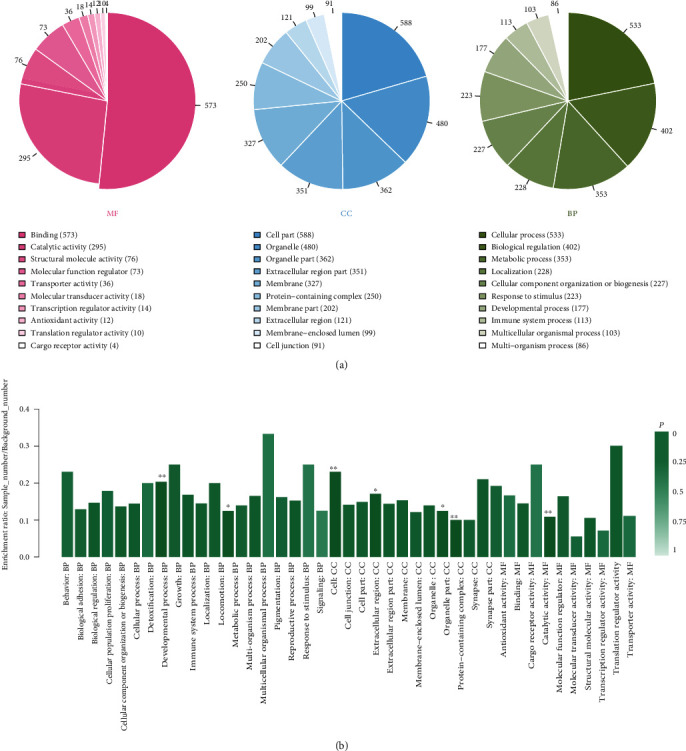
The Gene Ontology (GO) enrichment of 132 differential abundance proteins (DAPs). (a) Sorted by descending order of the number of protein associated with the listed GO ID. (b) Sorted by descending order of P value for the GO enrichment terms. Because of the limited number of patients, we considered DAPs as meaningful only as strong differently expressed (∣log2FC | >2).